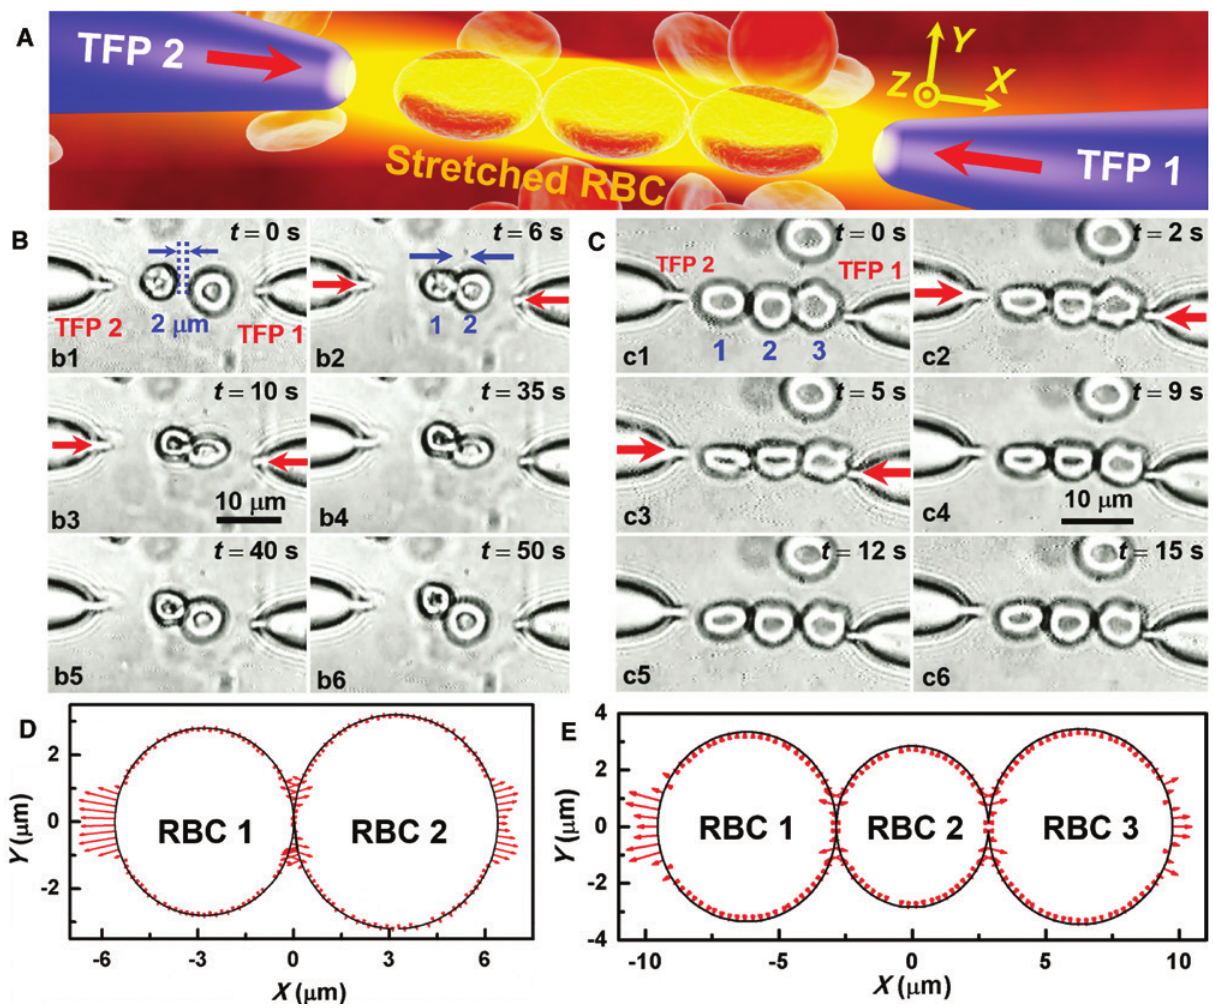
Figure 4: Stretching multiple RBCs with light from two TFPs. (A) Schematic of stretching multiple RBCs by using two TFPs. (B) Optical micro- scopic images for stretching two RBCs. (C) Optical microscopic images for stretching three RBCs. (D) Stress distribution on the surfaces of the two RBCs. (E) Stress distribution on the surfaces of the three